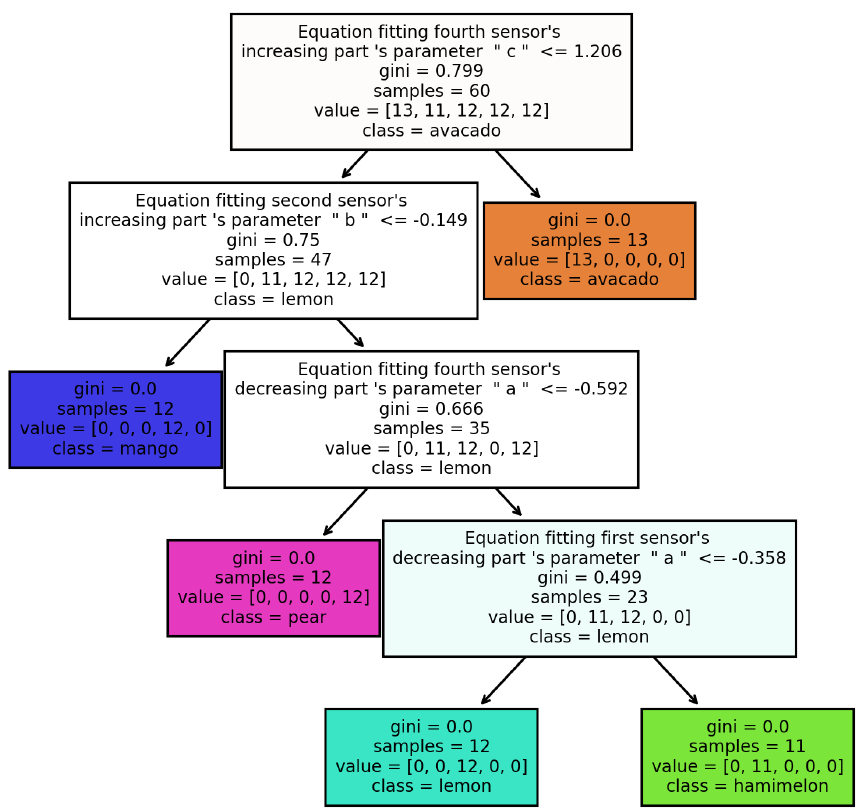
Figure 4. The process and result of a decision tree model for classifying 5 types of fruits. The first node on the top relies on the parameter “c”, from equation (1) fitting of MQ3 response to separate the avocado samples from the whole training dataset. Other nodes use the same process to classify the fruits.